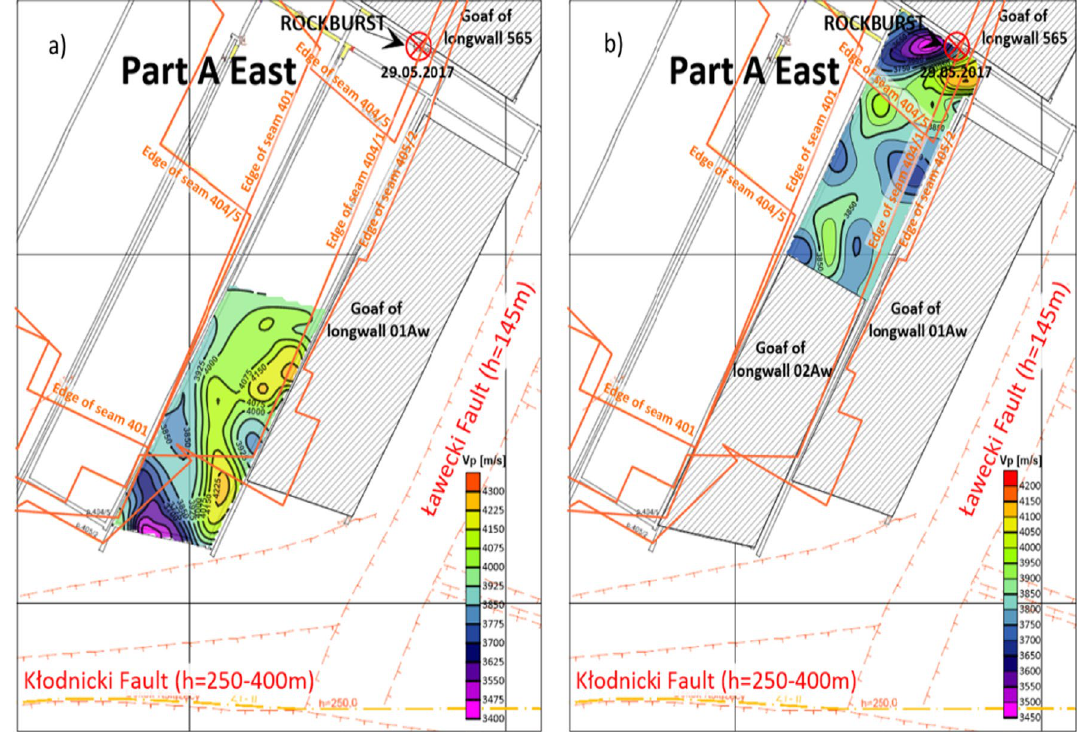
Fig. 4 Results of seismic measurements in the longwall 02Aw panel using active seismic geotomography: a 1st cycle b 2nd